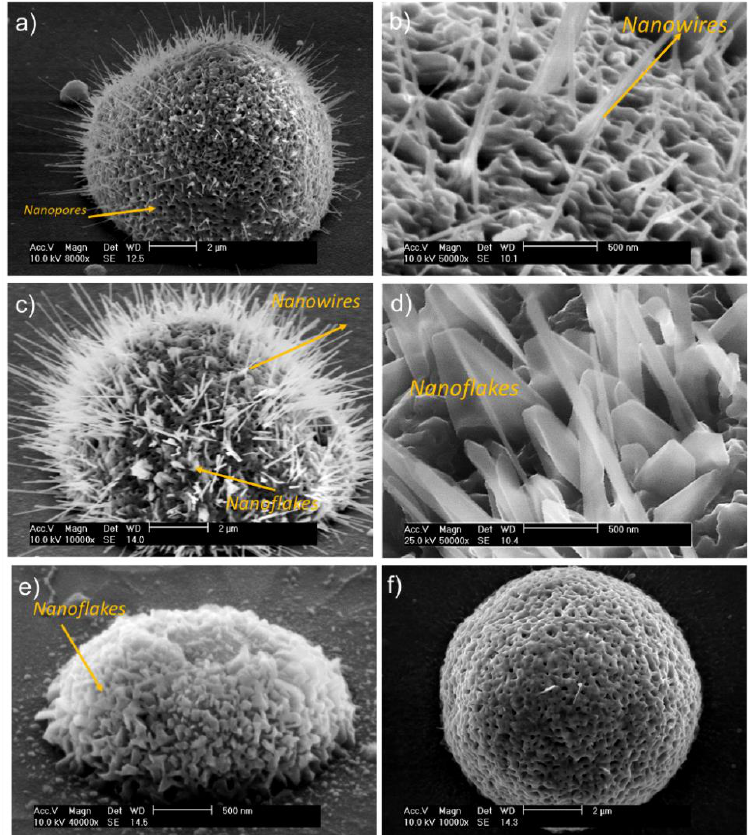
Figure 3. Fe microspheres (average diameter, D = 10 µ m) after carbothermal heat treatment at ( a , b ) 750 °C and ( c , d ) 800 °C. The size and features of the iron oxide nanostructure sensitively change with temperature; ( e ) limited growth of nanoflakes on smaller Fe microspheres ( D = 1.8 µ m diameter); ( f ) reference Fe microsphere heat-treated in air.